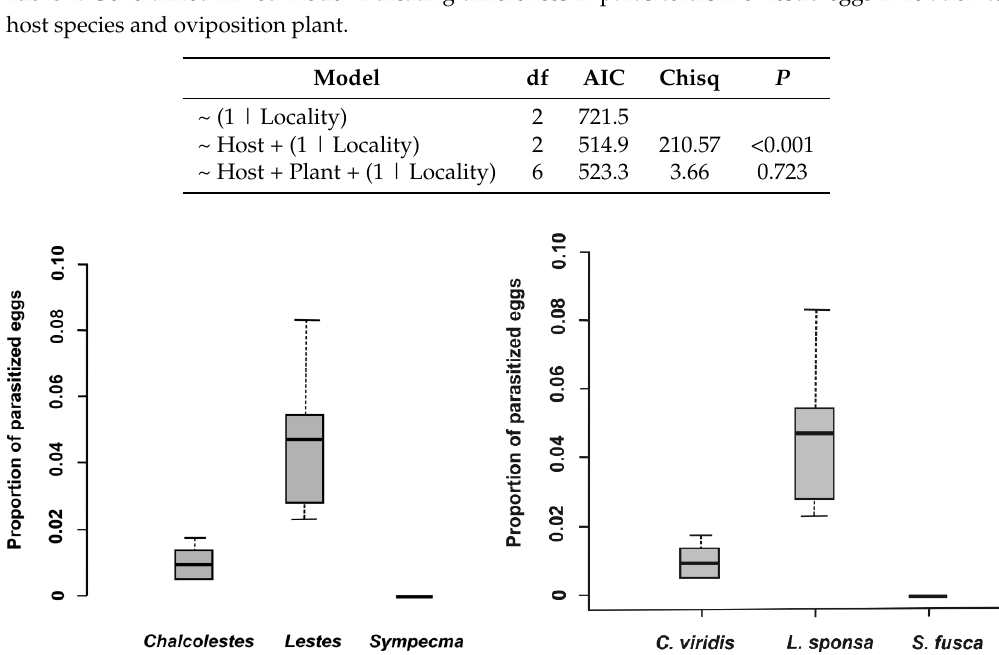
Figure 1. Proportion of parasitized eggs per damselfly species.